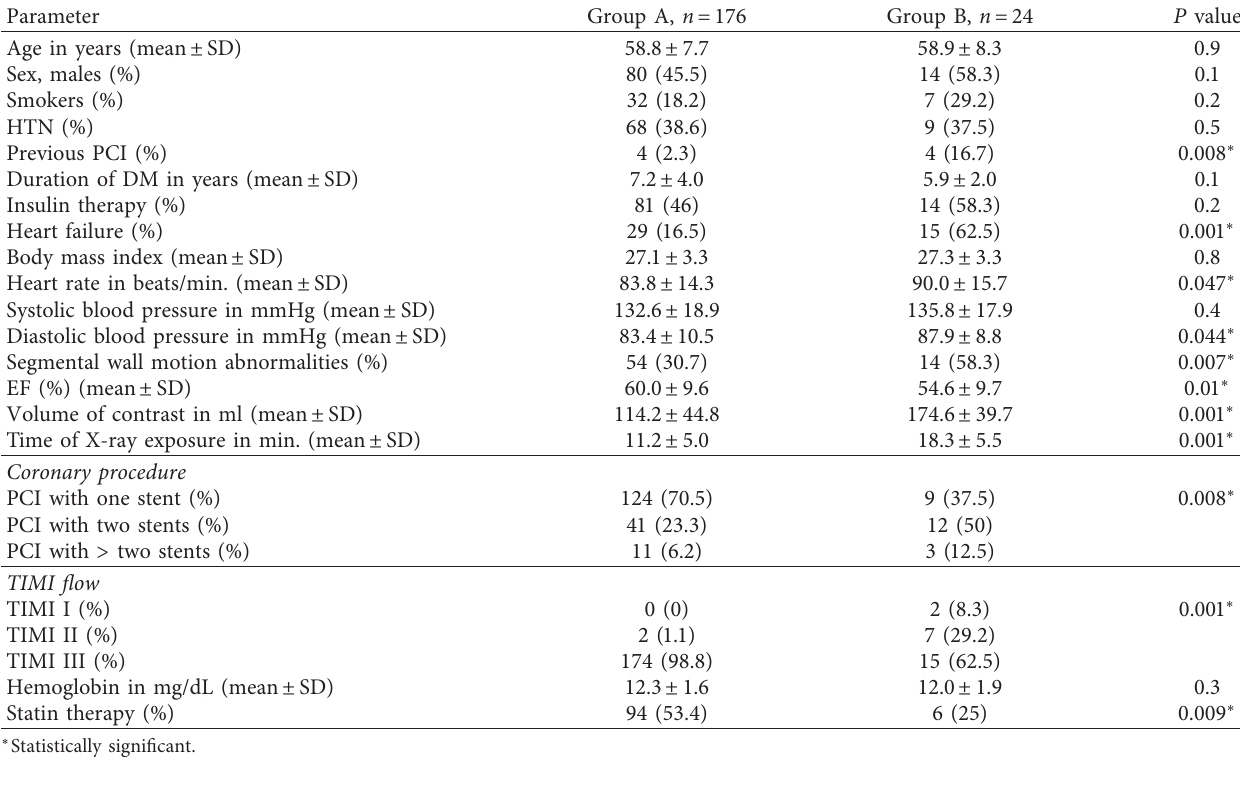
Table 4: Demographic, clinical, echocardiographic, and laboratory data of the two groups.